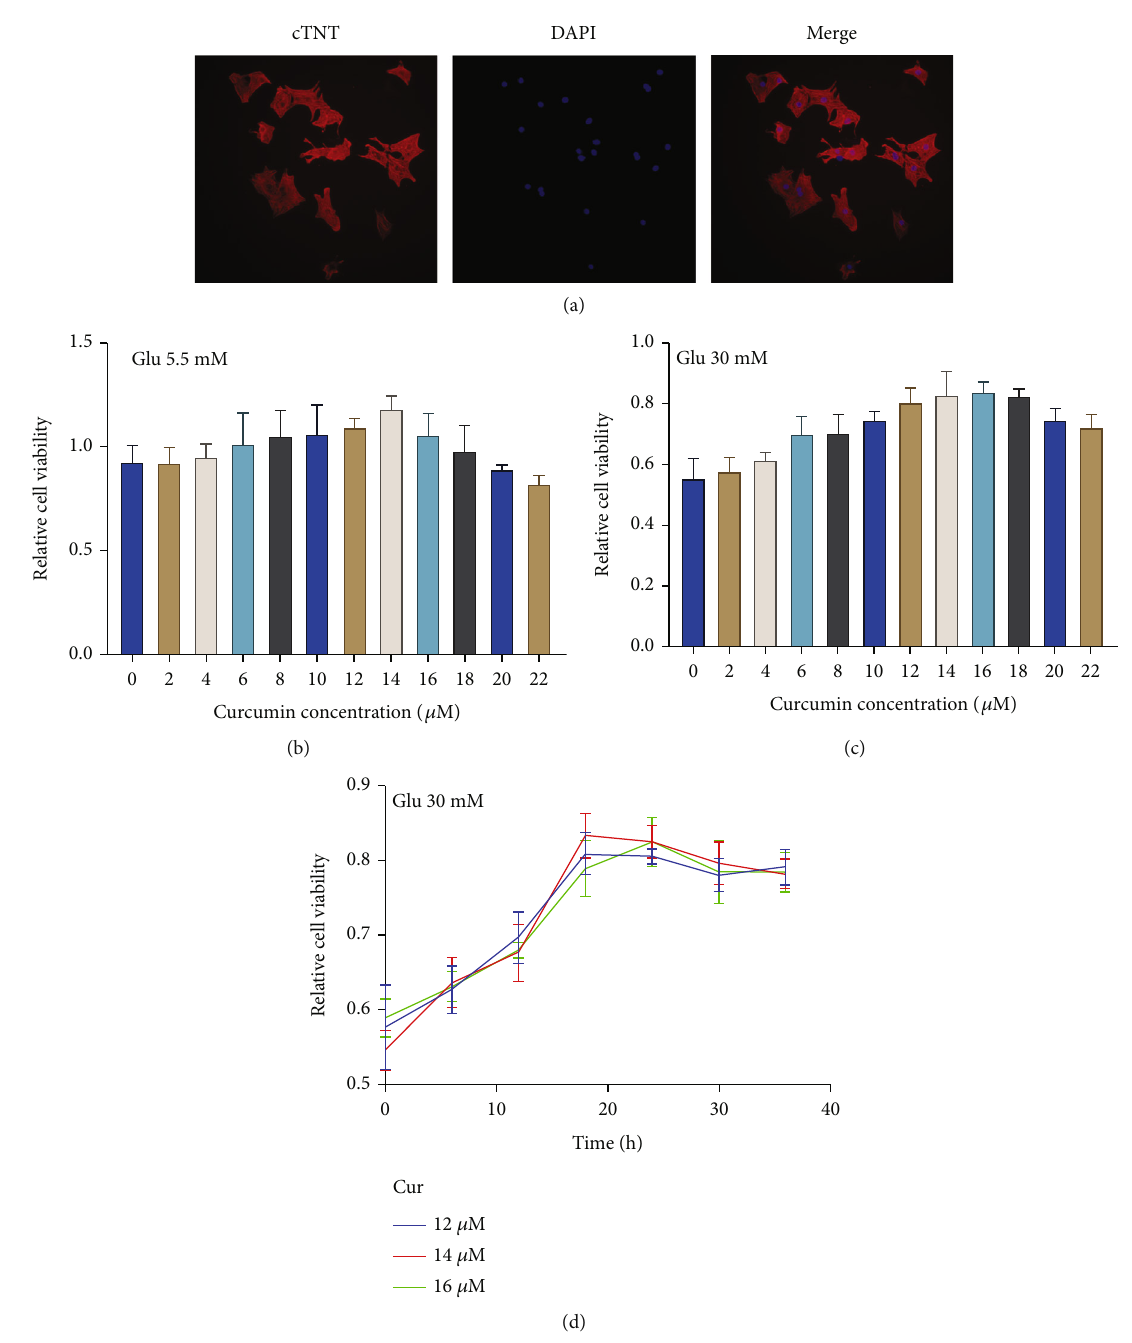
Figure 1: Detection of cardiomyocyte purity and cell viability. Glu: glucose. (a) Troponin was used to identify cardiomyocytes; cardiomyocyte purity was more than 90% (20x). (b) In a 5.5mM glucose medium, the CCK-8 test was used to measure the impact of various curcumin concentrations on cardiomyocyte activity. (c) In a 30mM glucose medium, the CCK-8 test was used to measure the impact of various curcumin concentrations on cardiomyocyte activity. (d) Cell viability over time in cardiomyocytes under di ff erent curcumin concentrations. Values are displayed as the mean and standard